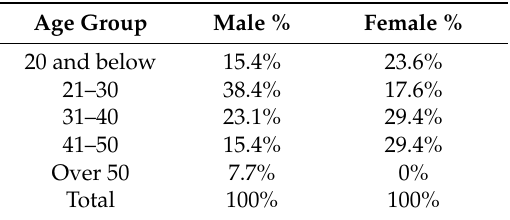
Table 1. Interview respondents’ age-gender cross